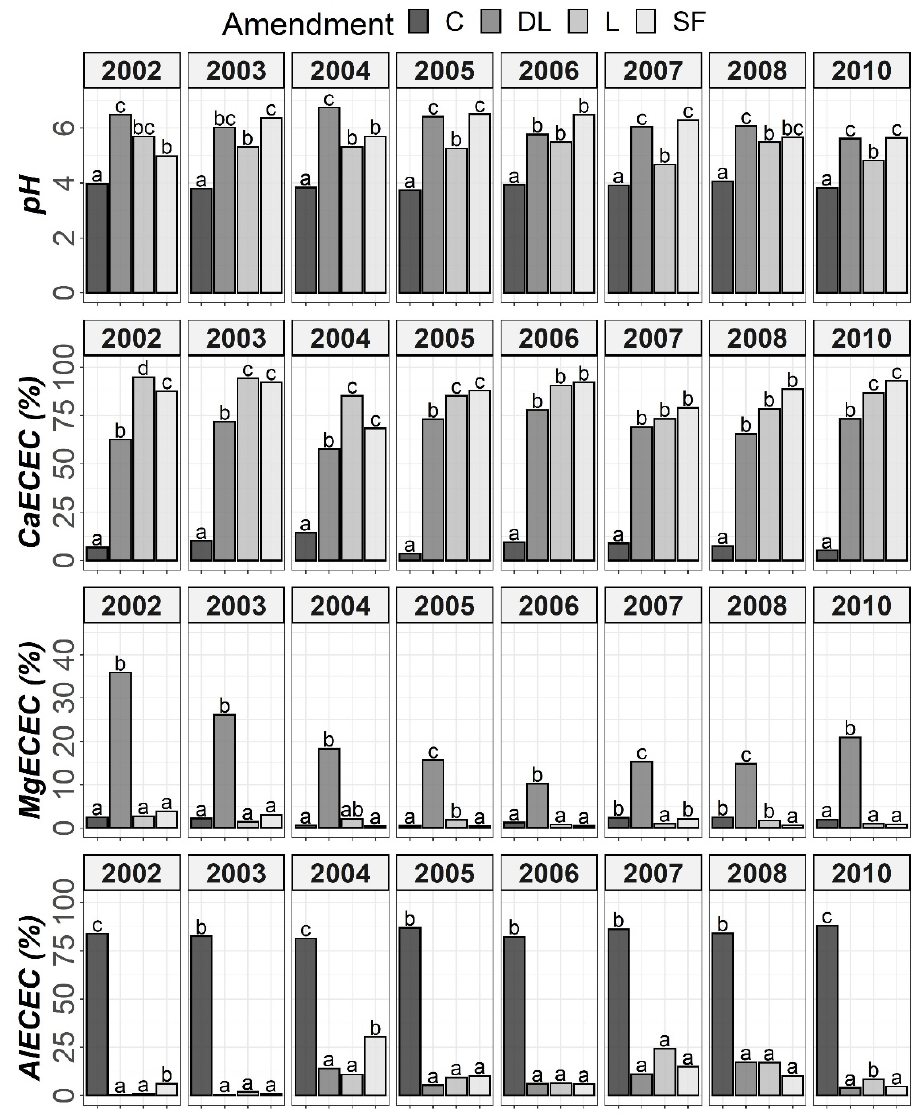
Figure 3. Temporal evolution of pH, CaECEC, MgECEC and AlECEC in the Ap1 horizon throughout the soil monitoring period (2002–2010). Bars within each year followed by different lowercase letters reflect significantly different averages according to Tukey’s honest significance test with Holm–Bonferroni adjustment ( p = 0.05).